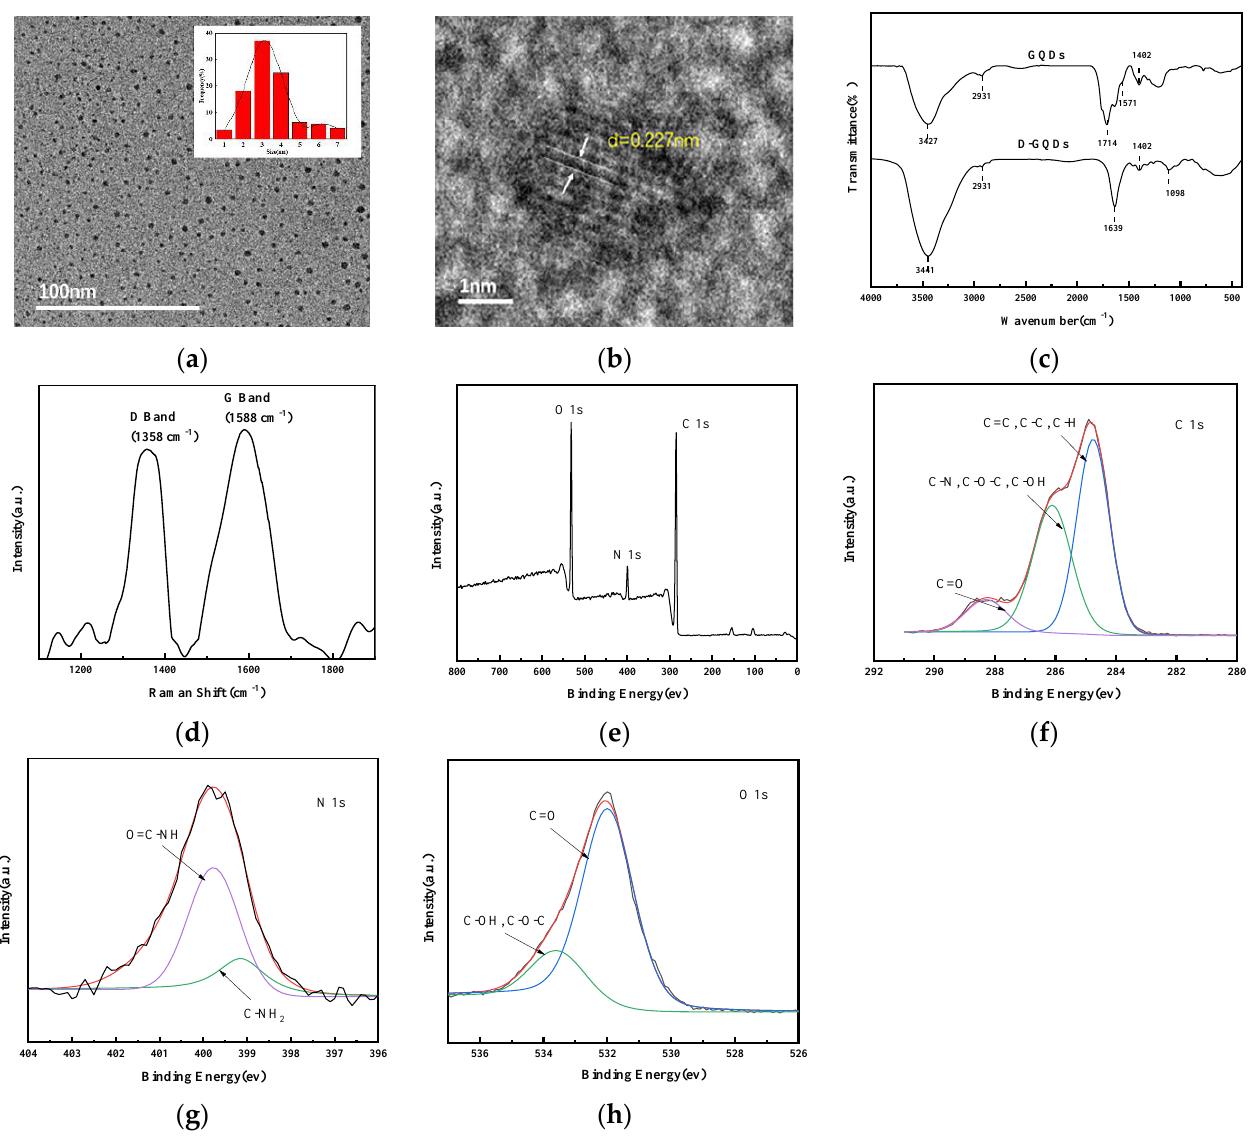
Figure 1. ( a ) TEM image (inset: particle − size distribution), ( b ) HRTEM image, ( c ) FTIR spectra, ( d ) Raman spectra, ( e ) XPS spectra and high − resolution XPS spectra of ( f ) C 1 s, ( g ) N 1 s, ( h ) O 1 s of D-GQDs.